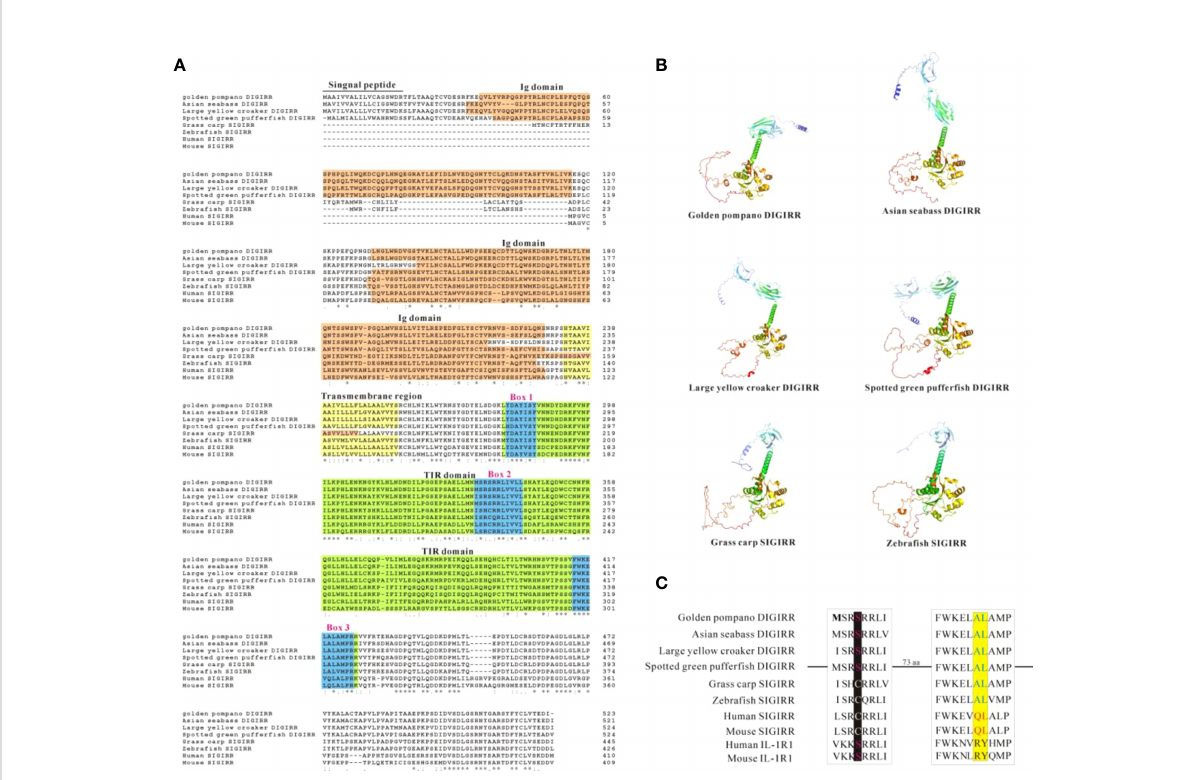
FIGURE 2 Comparison of DIGIRR, SIGIRR predicted amino acid sequence (A) , 3-D structure (B) and TIR domain key amino acid (C) in different vertebrates. The underlined part was the signal peptide and the red shaded part was the Ig domain. The yellow shaded part was transmembrane region. The green shaded part was TIR domain and the blue box (1-3) was the Box motif in the TIR domain. The 3-D structure was performed using Alpha fold 2 software. The GenBank accession numbers of each specie sequences were summarized in Table